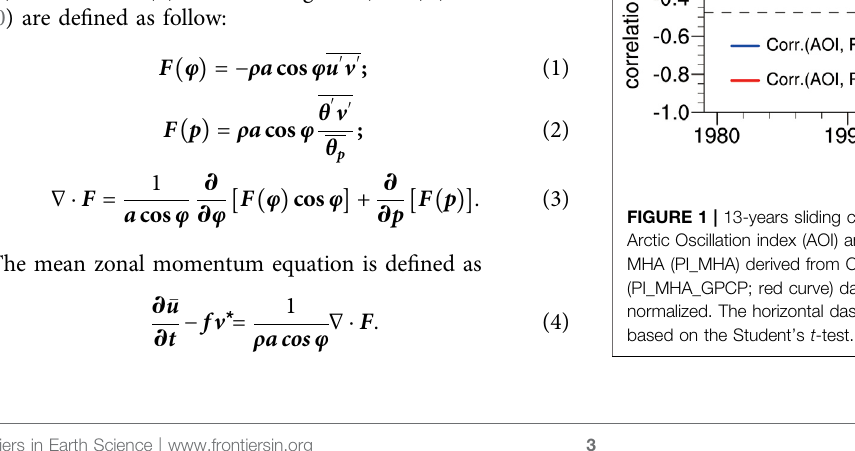
Frontiers in Earth Science |